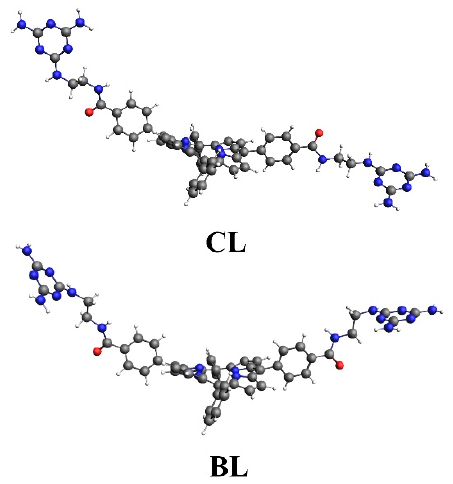
Figure 1. Labeling of the bonds for which the PES scan has been performed. µ represents the bond with the meso substituent.